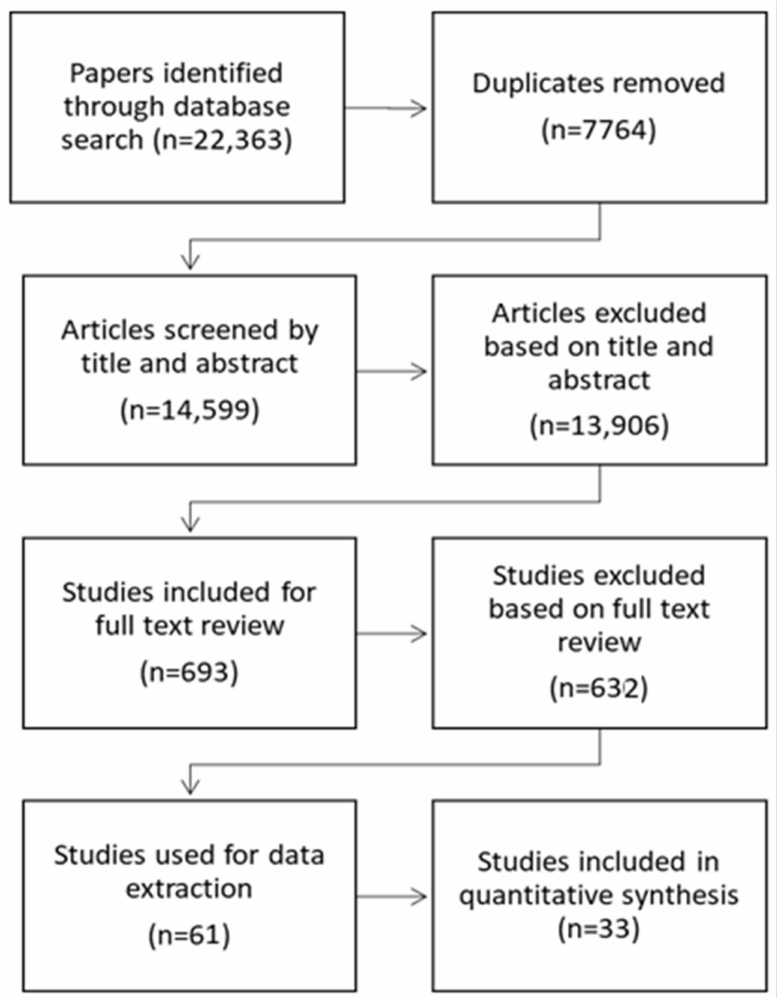
Figure 1. PRISMA